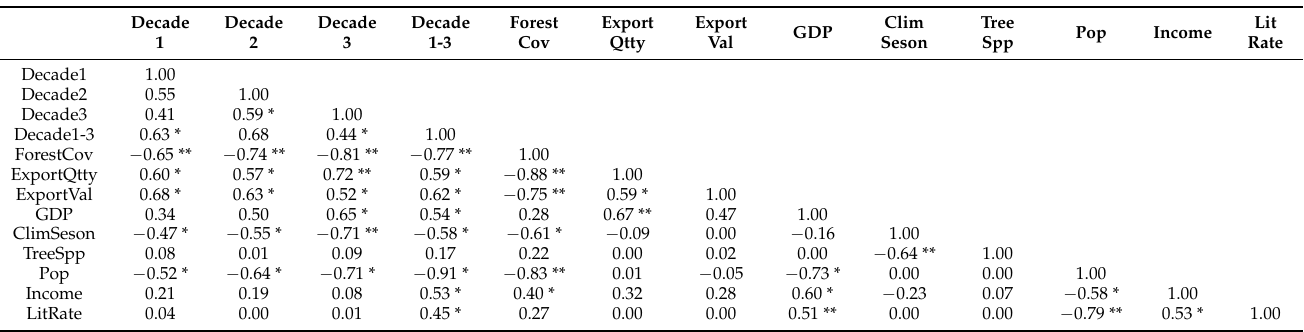
Table 2. Summary of Correlation analyses among the studied parameters. Decade 1 (1990–1999), Decade 2 (2000–2009), and Decade 3 (2010–2019), Decade 1-3